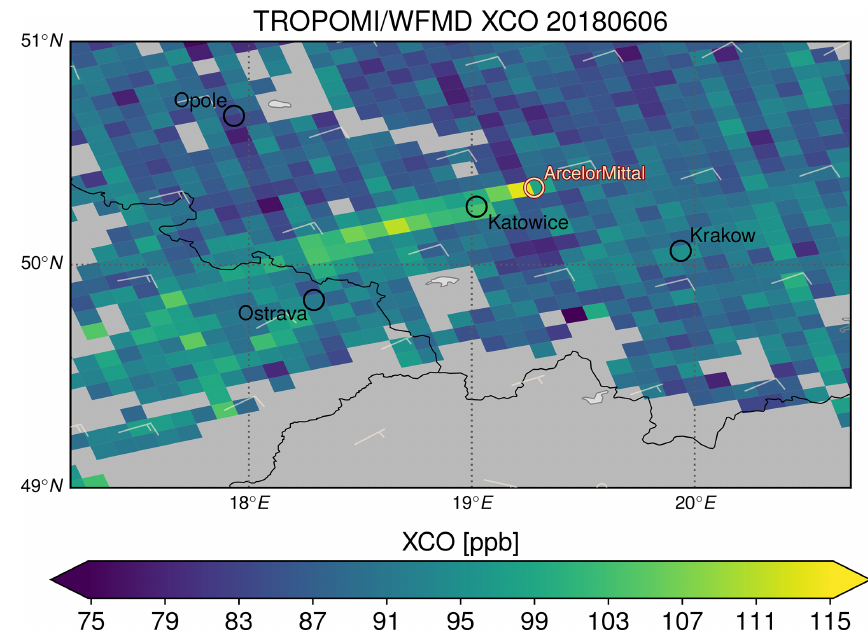
Figure 20. Carbon monoxide enhancement due to emissions from the ArcelorMittal steel plant in D ˛abrowa Górnicza in the Upper Silesian metropolitan area in Poland. Also shown is the mean wind in the boundary layer obtained from ECMWF data.